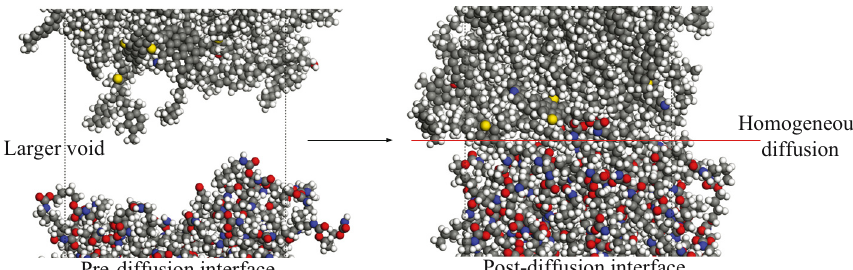
Figure 10: Di ff usion interface model of asphalt and PU.